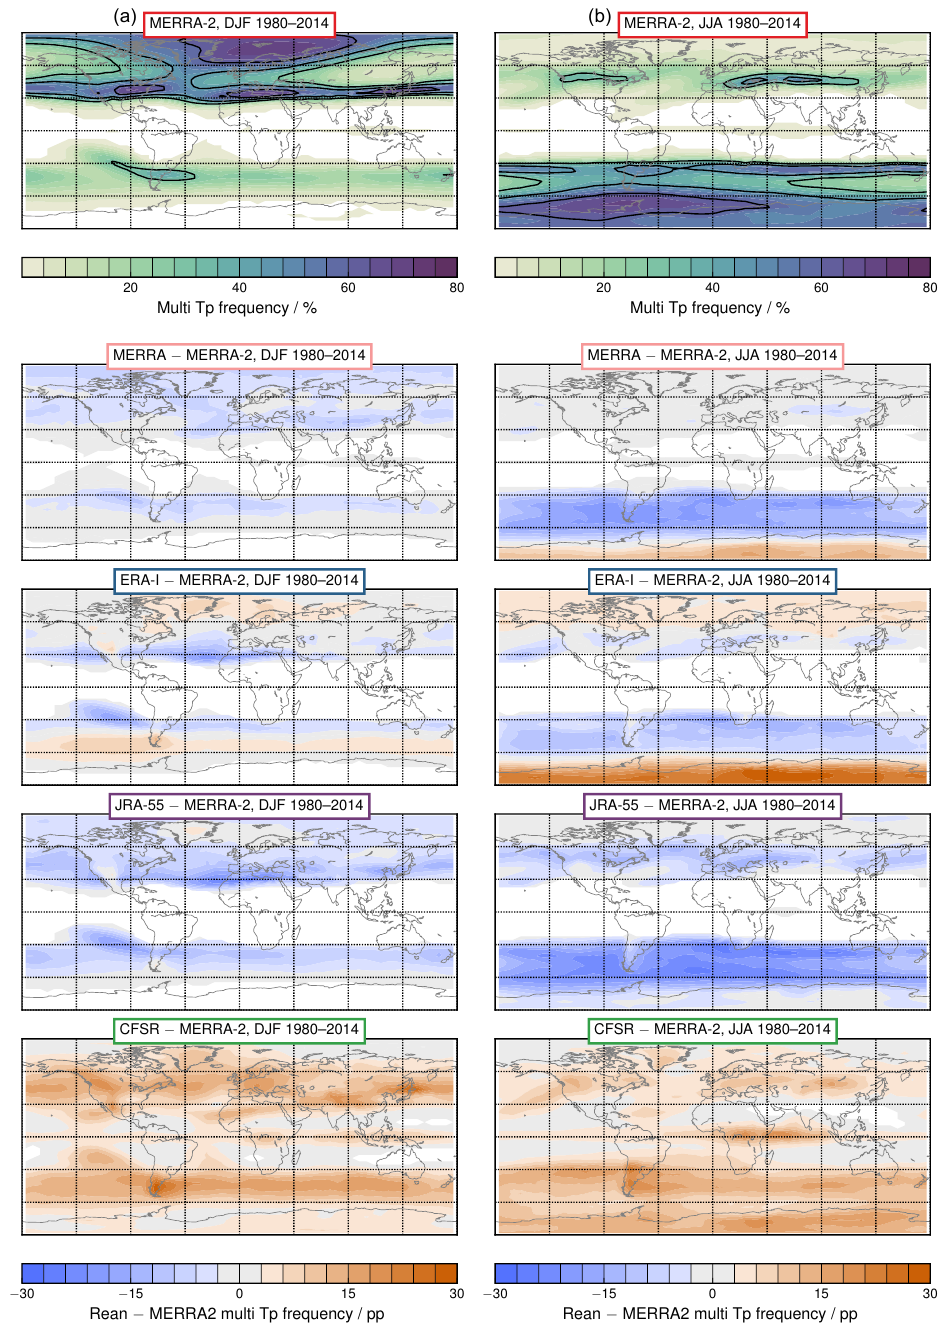
Figure 9. As in Fig. 7, but for multiple tropopause frequency distributions. Overlaid contours show frequency values from each reanal- ysis of 30, 45, and 60%; the smallest value is always the largest or “outermost” contour. In the difference plots, blues/oranges indicate negative/positive